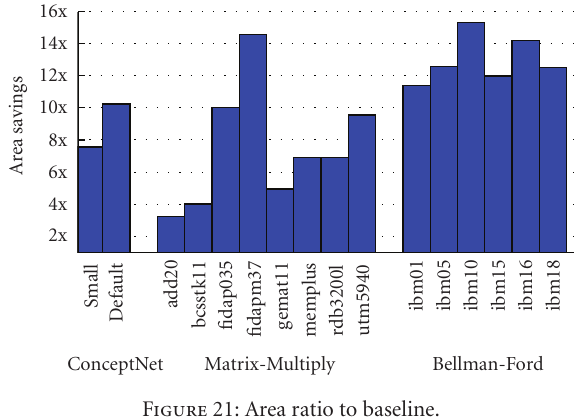
Figure 21: Area ratio to baseline.